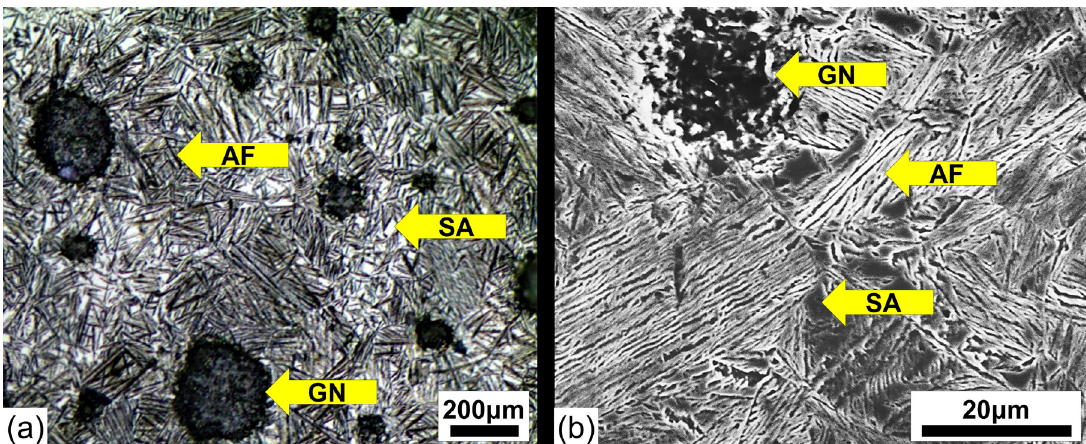
Figure 7. ADI microstructure (a) optical microscopy, where GN is Graphite Nodule, SA is Stabilised Austenite, and AF is Acicular Ferrite. (b) SEM